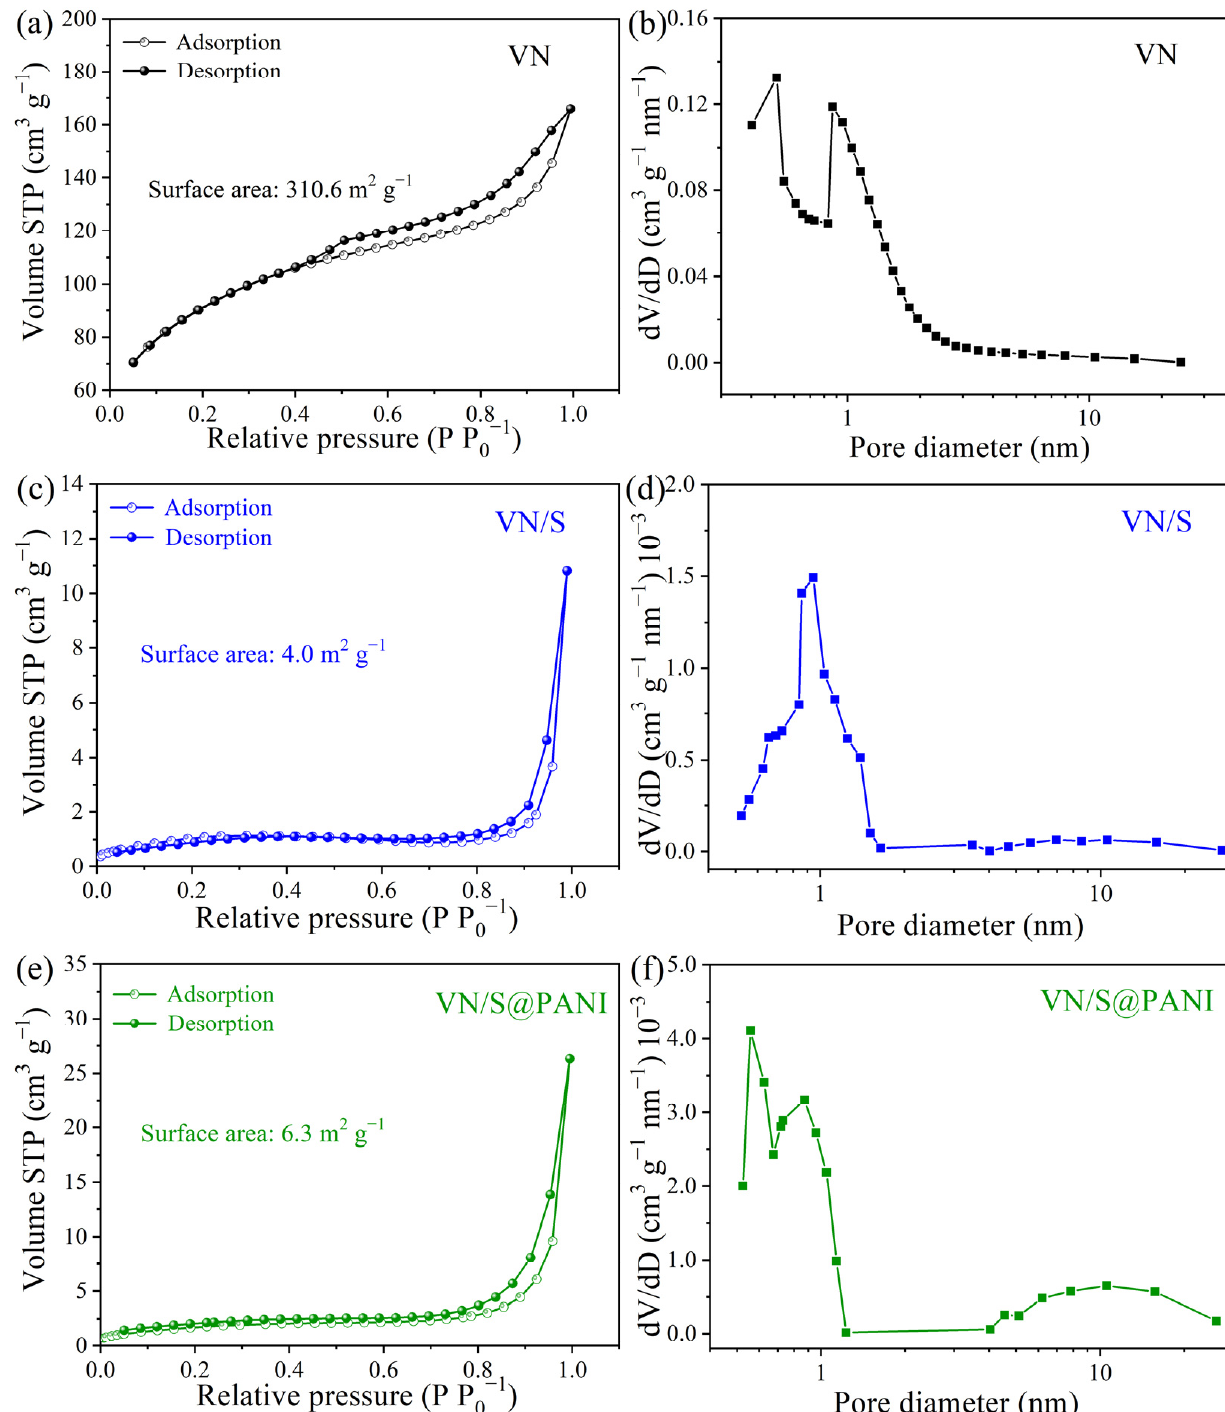
Figure 5. N 2 adsorption/desorption isotherms and corresponding pore size distribution curves of ( a , d ) VN microrods, ( b , e ) VN/S microrods and ( c , f ) VN/S@PANI microrods.